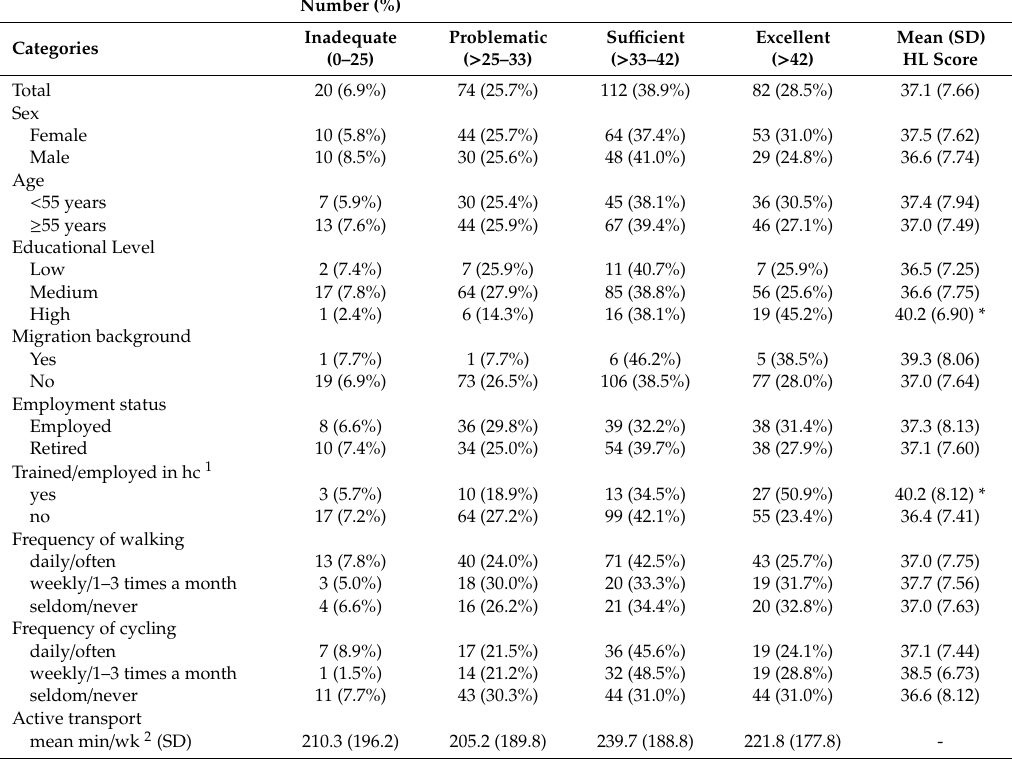
Table 3. Distribution of health literacy (HL) levels and HL scores of the study